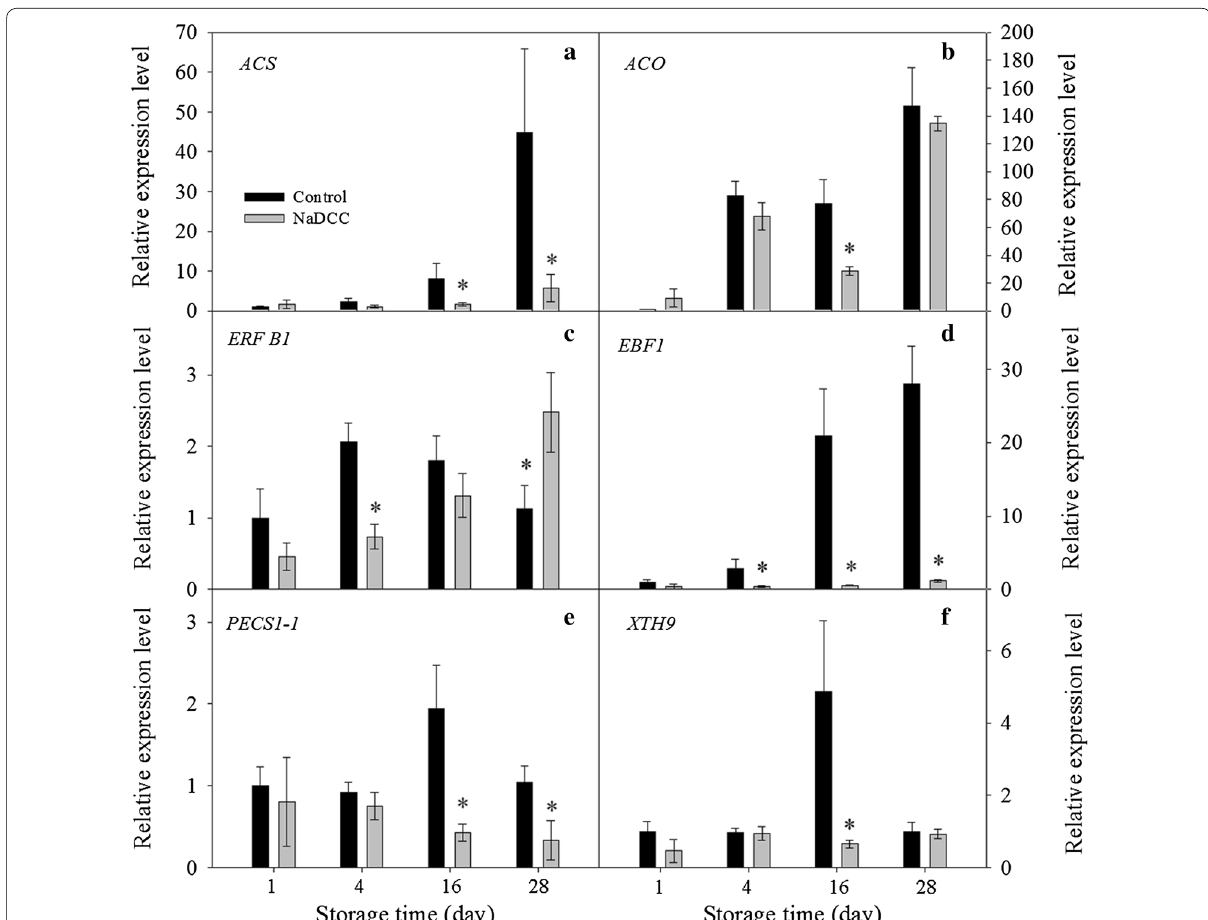
Fig. 5 Changes in the relative expression levels of peel tissue of banana fruit during storage. Gene expression in Control fruit after 1 day of storage was set as 1. Each data point represents a mean (from three separate groups) different ( p <